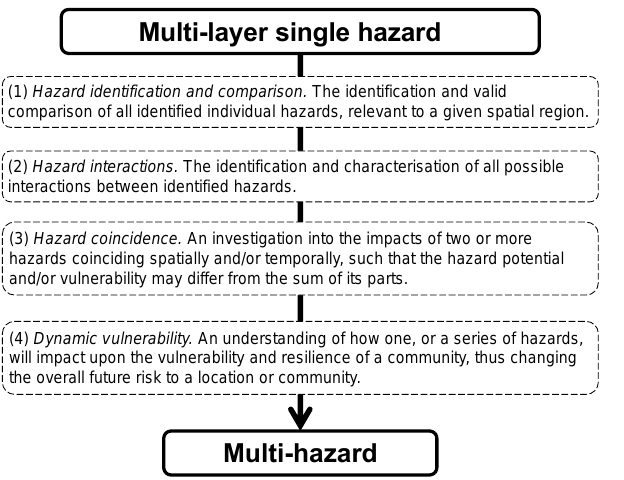
Figure 1. Multi-hazard risk framework (from Gill and Malamud, 2014). Shown is the progression from a multi-layer single-hazard approach to a full multi-hazard risk approach that includes (i) haz- ard identification and comparison, (ii) hazard interactions, (iii) spa- tial/temporal coincidence of natural hazards, and (iv) dynamic vul- nerability to multiple stresses (when progressing from the assess- ment of hazard to the assessment of